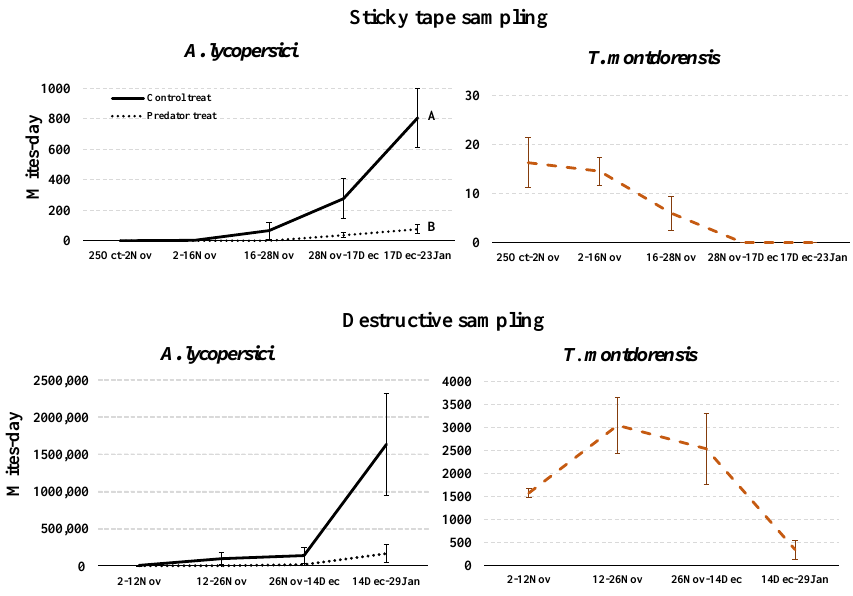
Figure 3. Densities of TRM and T. montdorensis (mite-days) per four leaves in the experiment with cages, autumn 2018. Counts were made using sticky tape or destructively by washing four leaves; the density of the collected mites was measured using a stereomicroscope (25×). Significant differ- ences between treatments are indicated by capital letters ( p < 0.05).